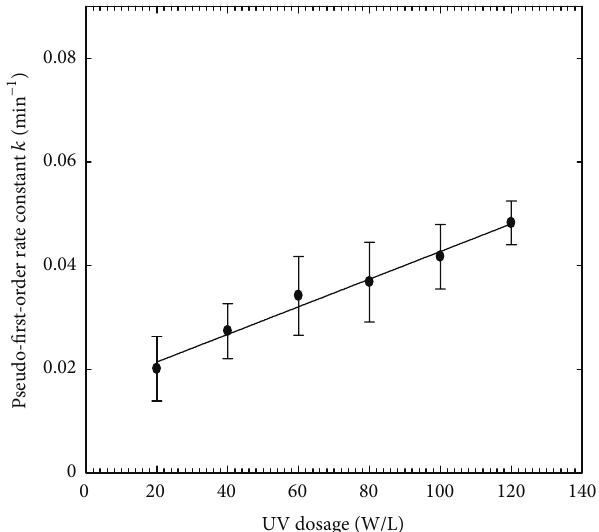
Figure 6: Effect of UV light intensity on pseudo-first-order rate constant of OG decolorization by UV/ZnO photocatalytic system. The conditions were the same as in Figure 5.